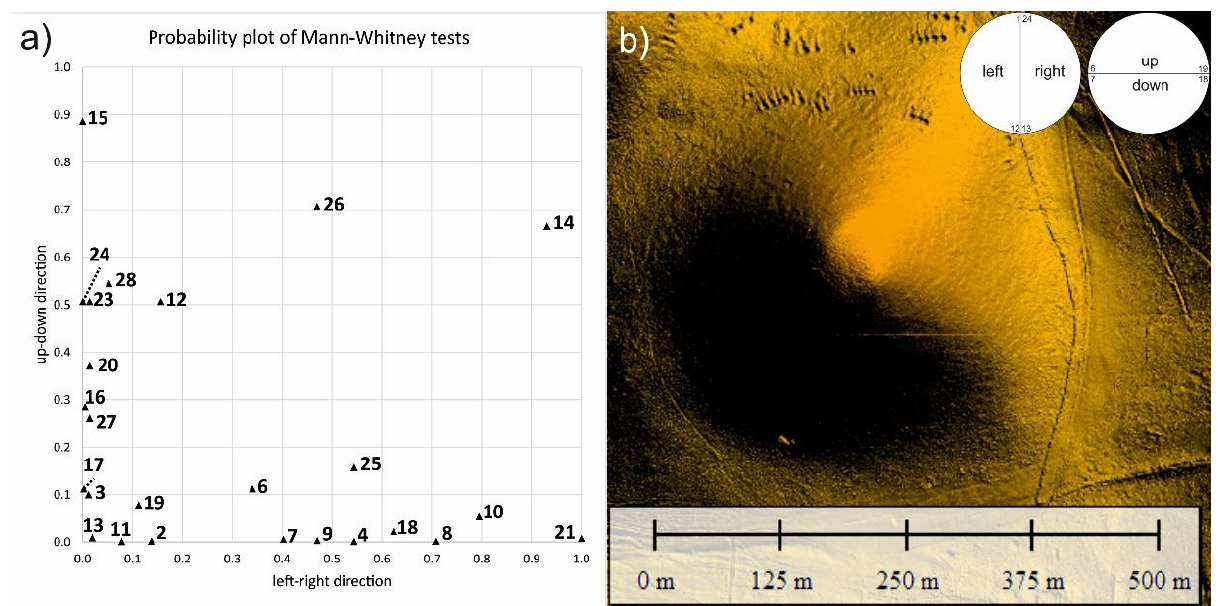
Figure 14. ( a ) probability plot of Mann-Whitney tests comparing the distributions of the left-right and up-down (forward backward) sectorial parts of each considered cones. The higher the value, the more symmetric the cone is in that directional sense; ( b ) cone 14, which is the most symmetric one according to the chart in the left panel. The definition of the two symmetry axes is right above.